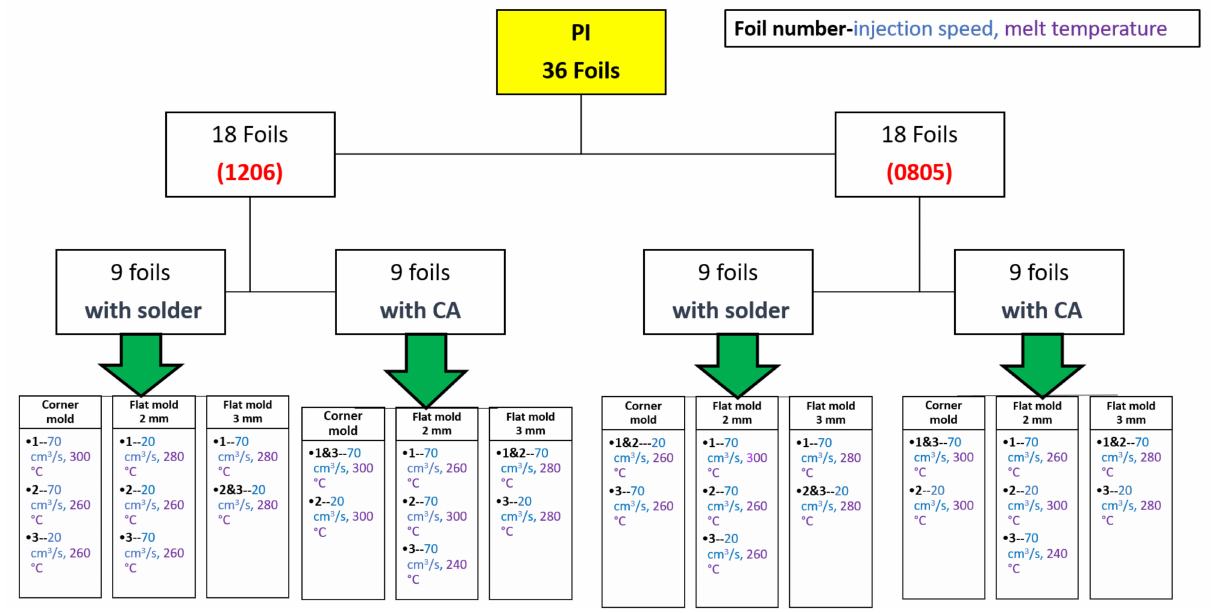
Figure 14. Overview of over-molded foils.